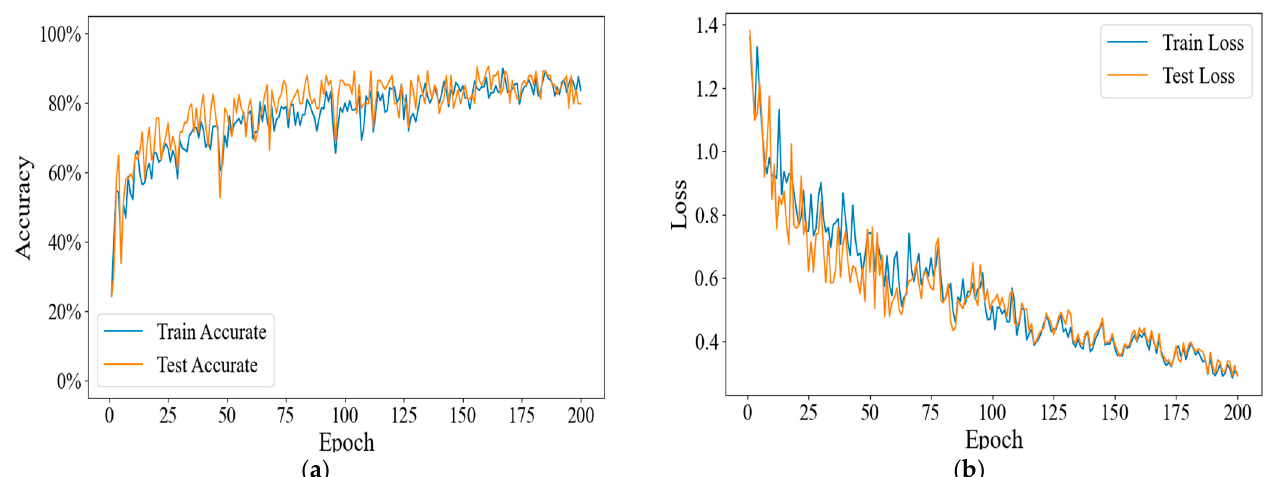
Figure 16. ( a ) Training and test accuracy curves of binary gas mixture datasets. ( b ) Training and test loss curves of binary gas mixture datasets.